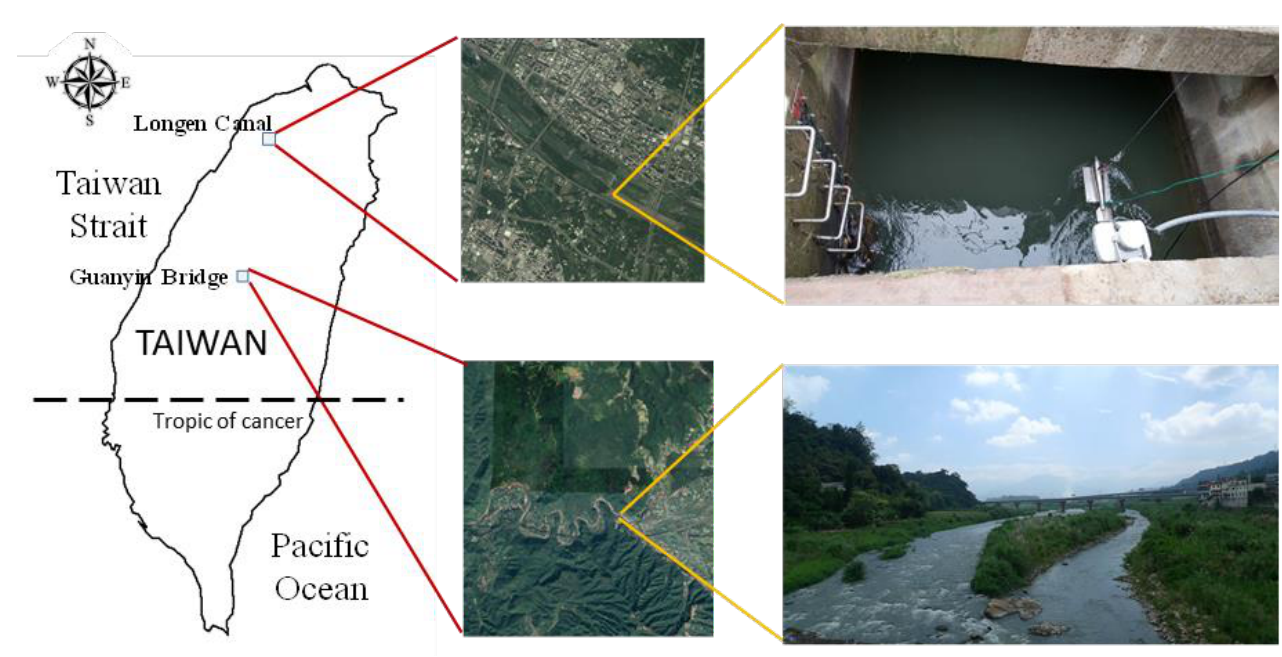
Figure 3. Study sites for discharge measurement.